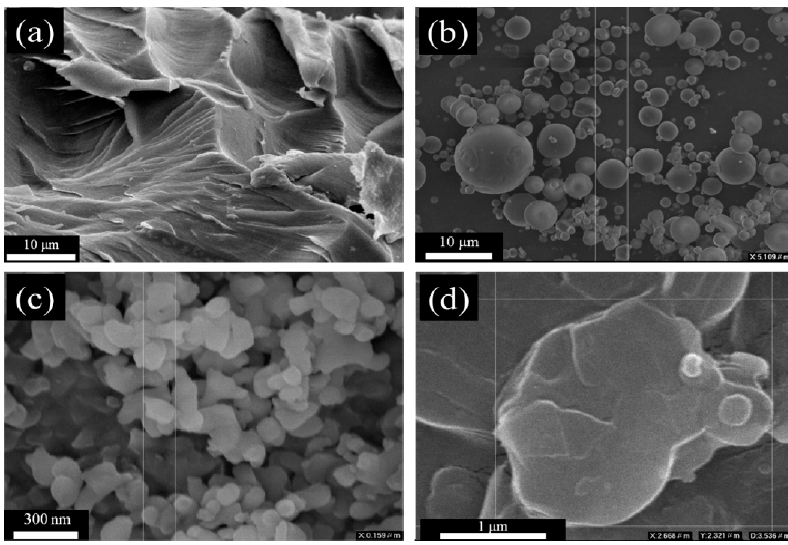
Figure 9. SEM micrographs of ( a ) EP; ( b ) m-Al 2 O 3 ; ( c ) n-Al 2 O 3 , and ( d ) BN.